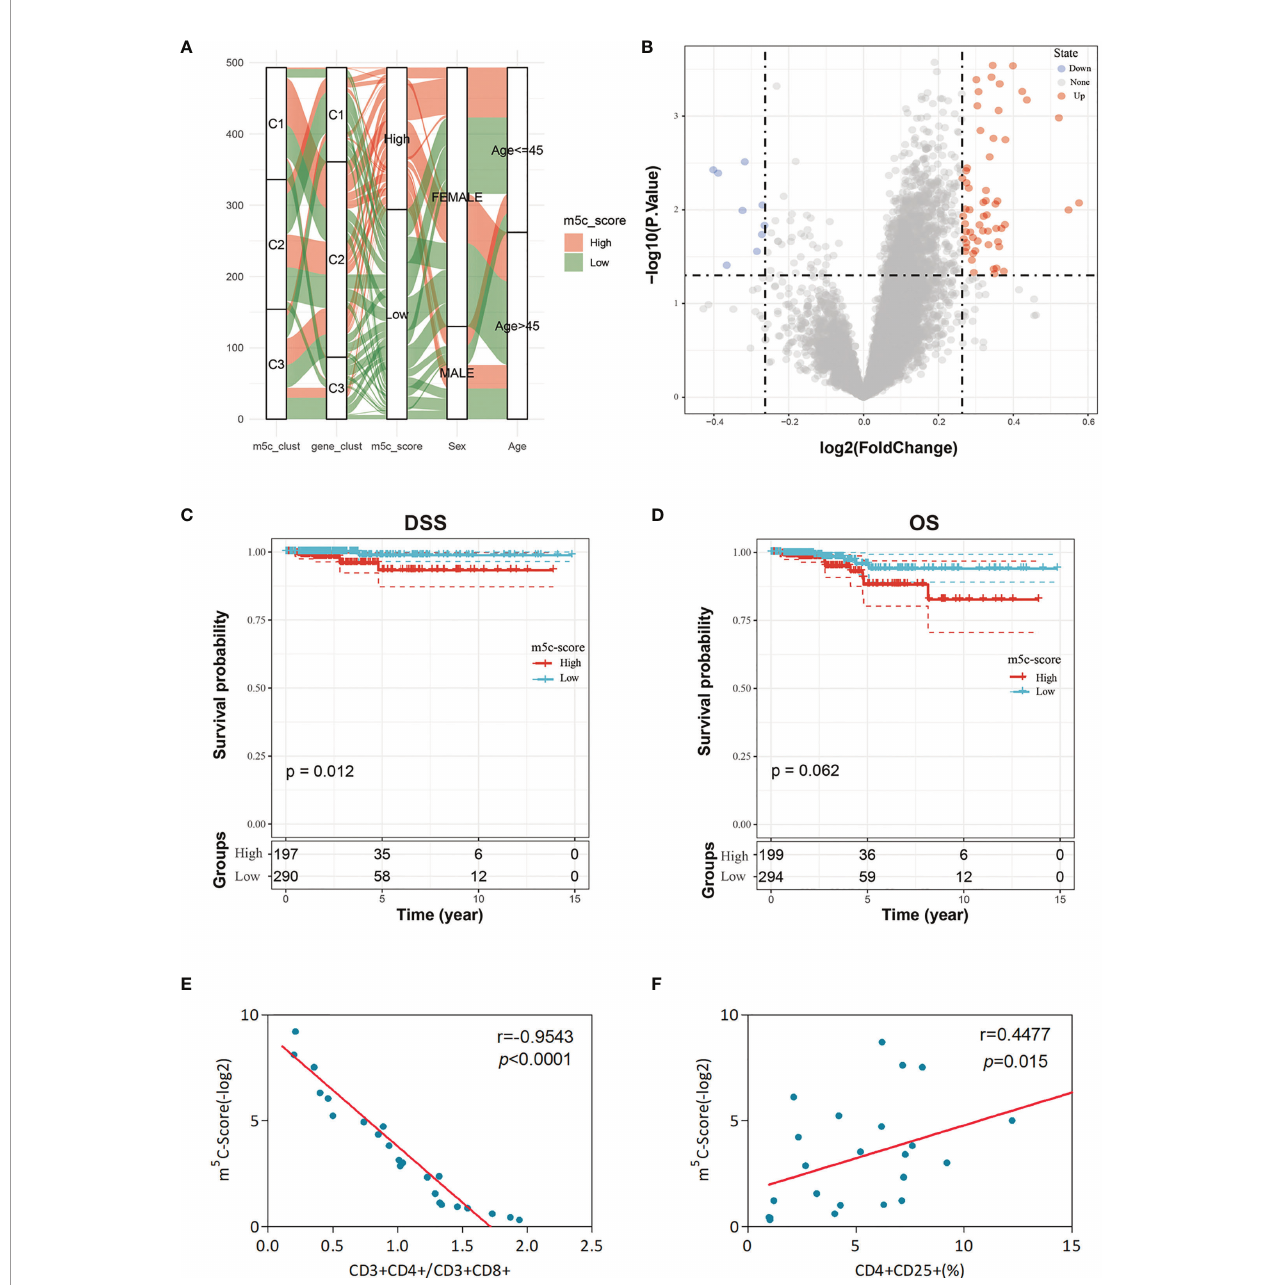
FIGURE 5 | Clinical features and transcriptome traits of the m 5 C-associated phenotypes. (A) Alluvial diagram showing the changes of m 5 C modi fi cation patterns, gender, age, gene cluster, and the m 5 C-score. (B) DEGs between high and low m 5 C-score samples. (C, D) Differences in DFS (C) and OS (D) between high and low m 5 C-score samples. (E) Relationship between the m 5 C-score value and the score of CD3+CD4+/CD3+CD8+ cells of the peripheral blood samples of 24 GBM patients. The m 5 C-Score value was negatively associated with the ratio of CD3+CD4+/CD3+CD8+ cells. (F) Relationship between the m 5 C-score value and the percentage of CD4+CD25+ Tregs in peripheral blood samples of the 24 GBM patients. The m 5 C-score value was positively related with the percentage of CD4+CD25+